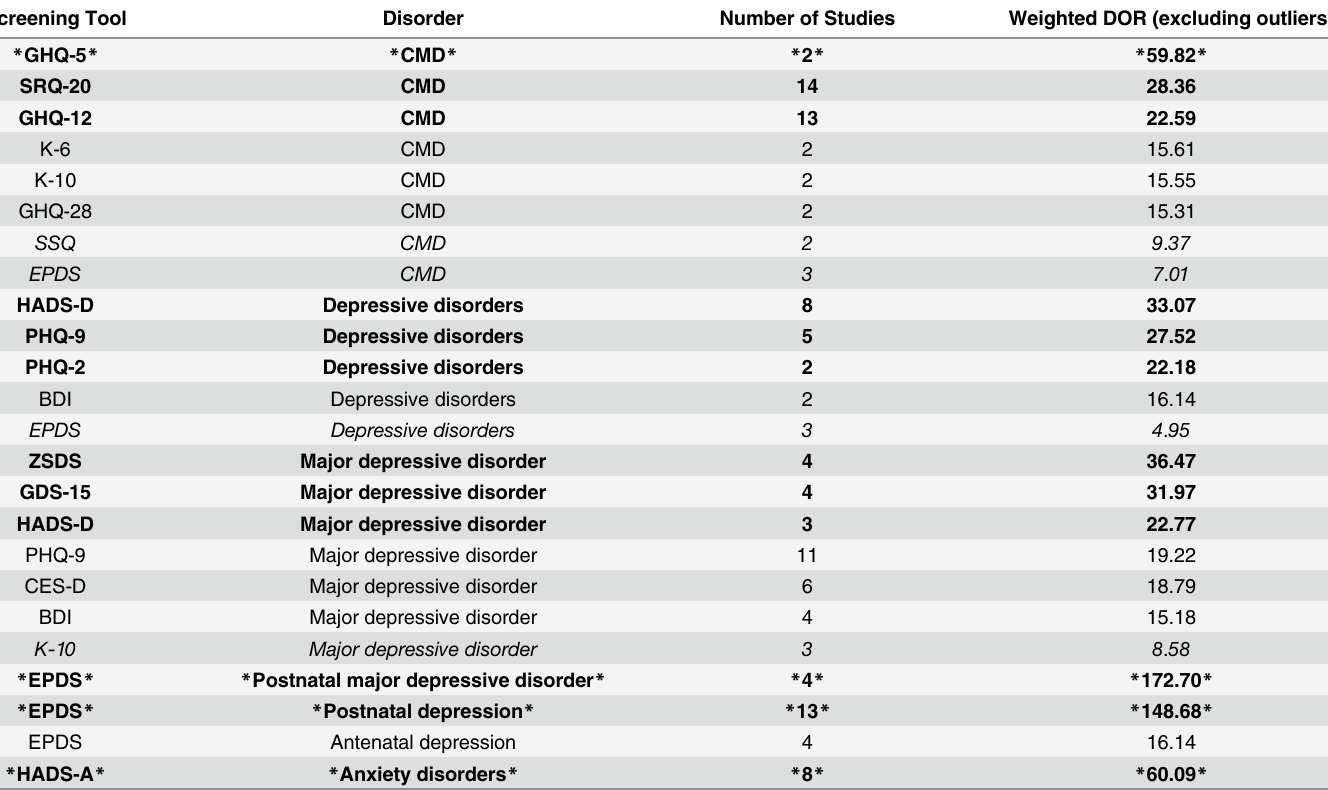
Table 5. Weighted diagnostics odds ratios (DORs) of selected screening tools. Screening